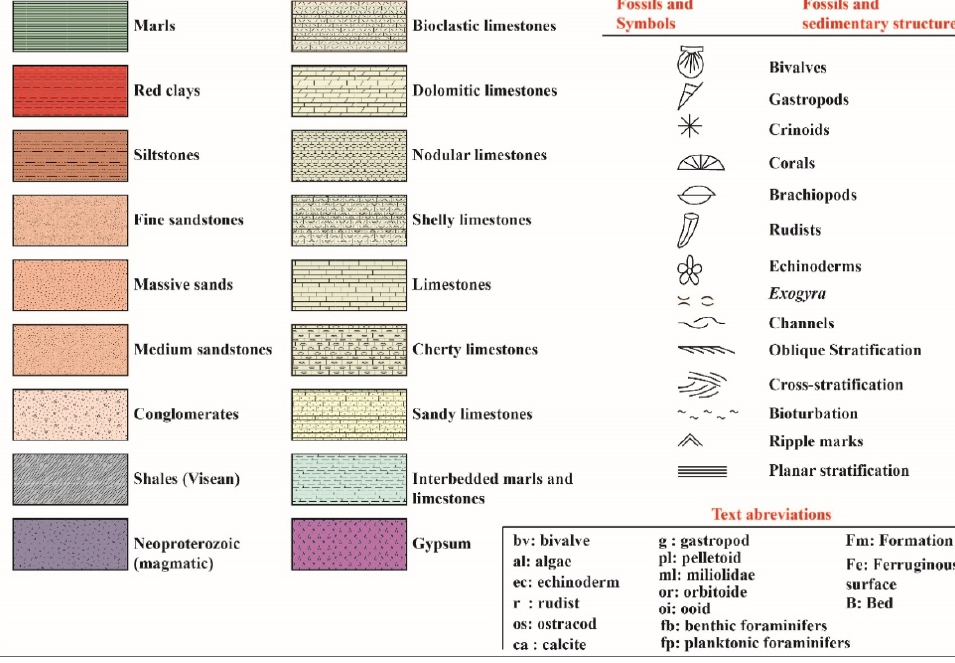
Figure 2. Graphic legend for columnar sections presented in this